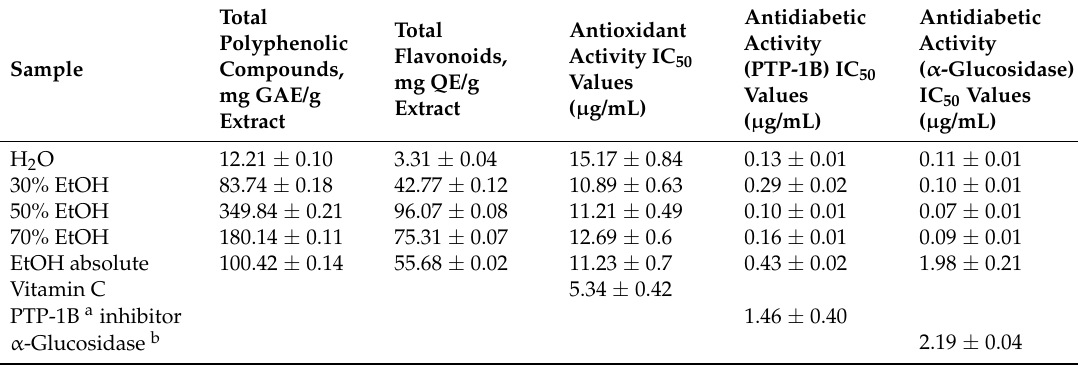
Results of the total polyphenolic compounds, total flavonoids, antioxidant and antidiabetic